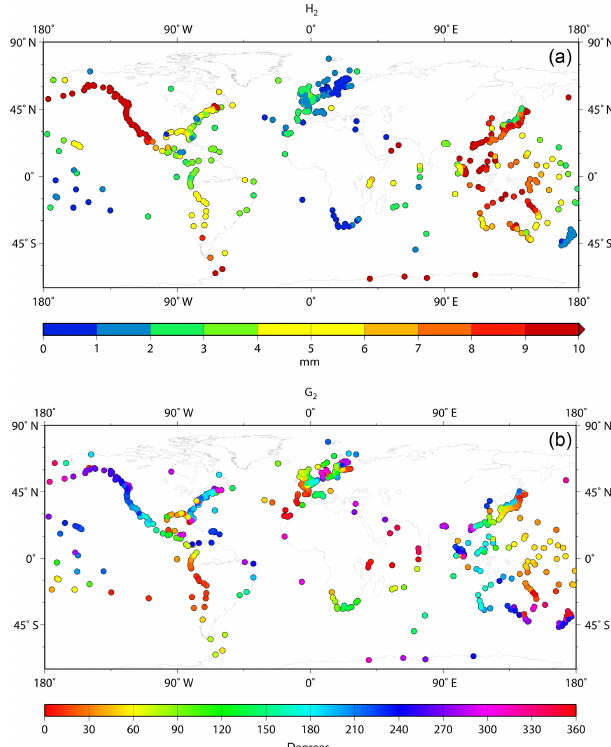
Figure 5. (a) Amplitude and (b) Greenwich phase lag of M1’ at stations in the GESLA-2 data set.